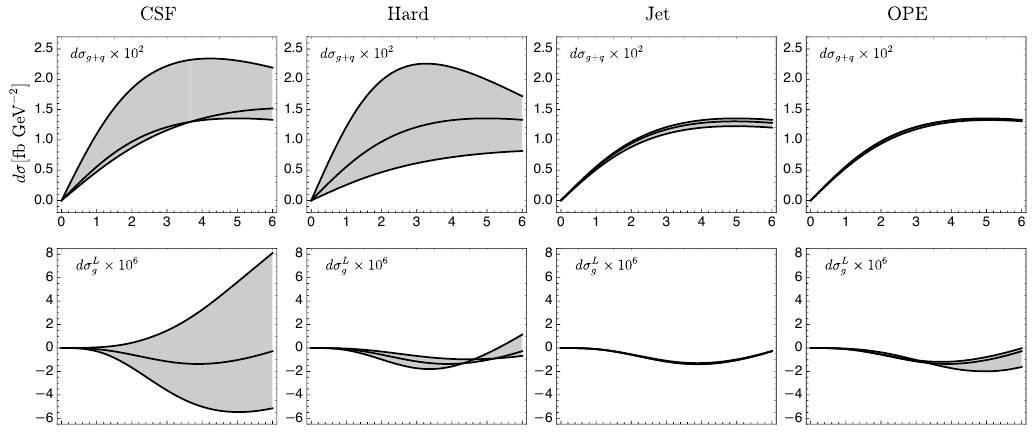
Figure 4. Cross-sections for dijet production at EIC with error-bands coming from scale de- pendence in collinear-soft factor (CSF), hard factor (Hard), jet distributions (Jet) and Wilson coefficients (OPE). Rows correspond to contributions from linearly polarized gluons (top) and total √ cross-section (bottom). s = 140 GeV, R = 0 . 7 , p T = 20 GeV, η 1 = η 2 = 0 .